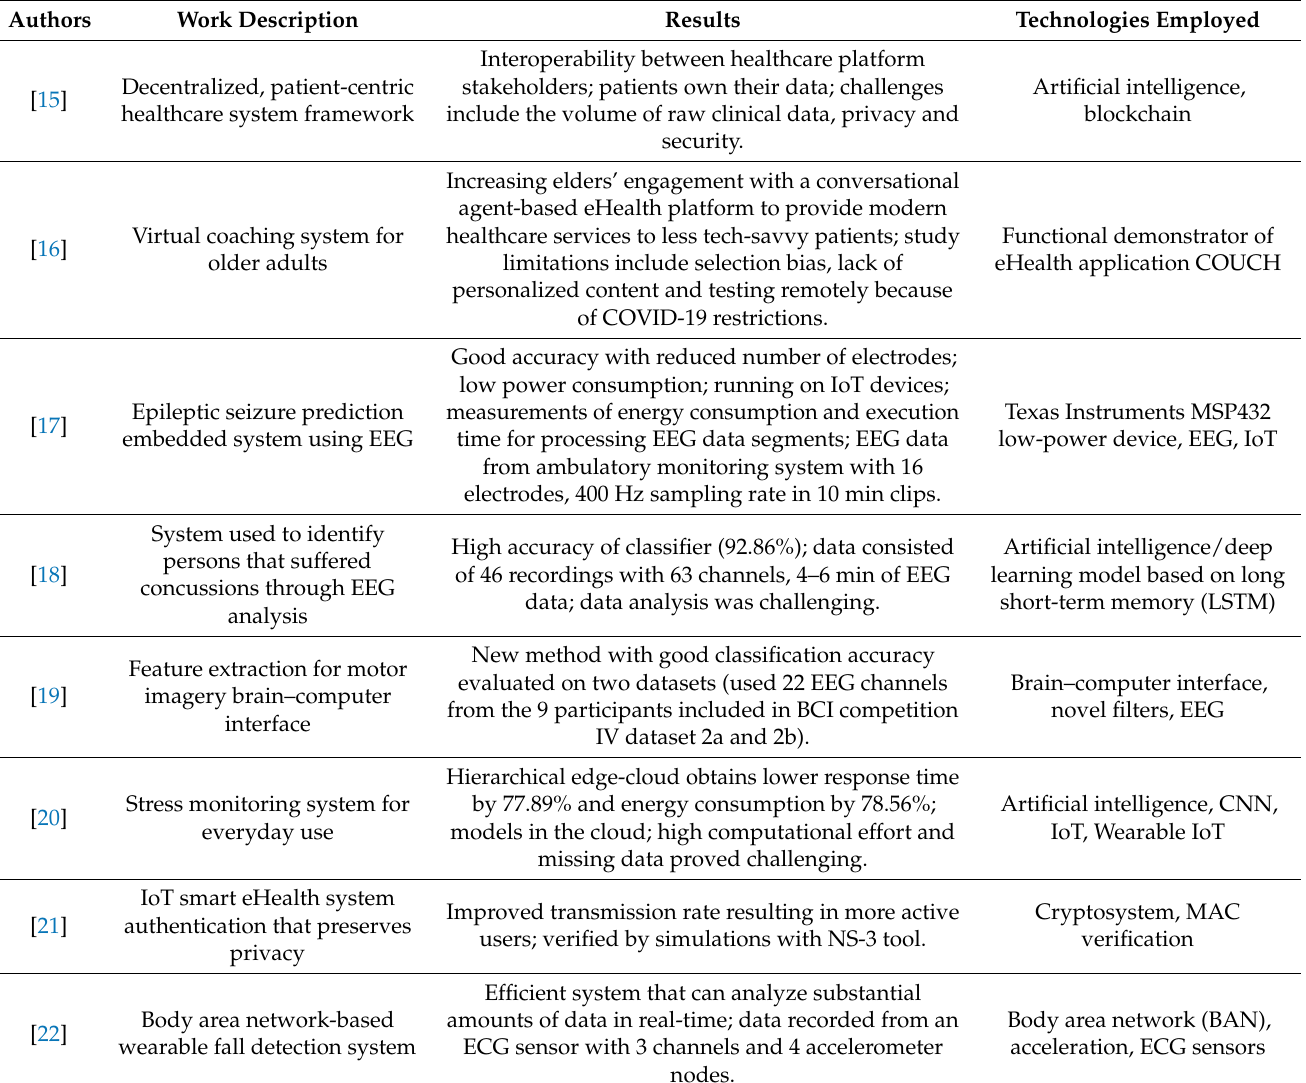
Table 1. eHealth